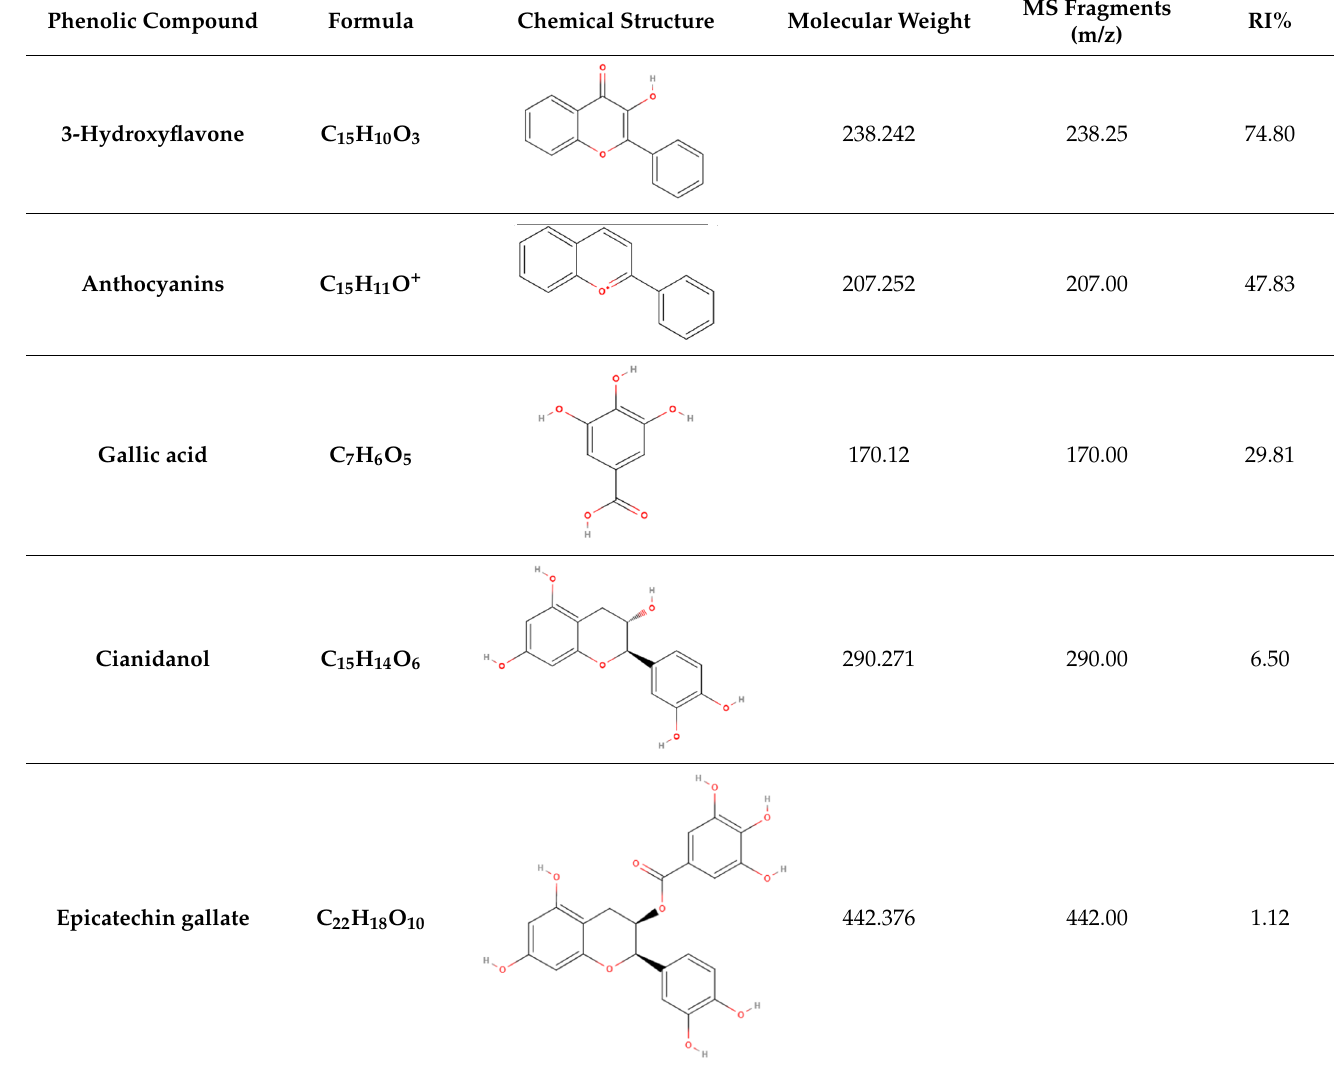
Table 2. GC/MS analysis of GSE phenolic constituents.